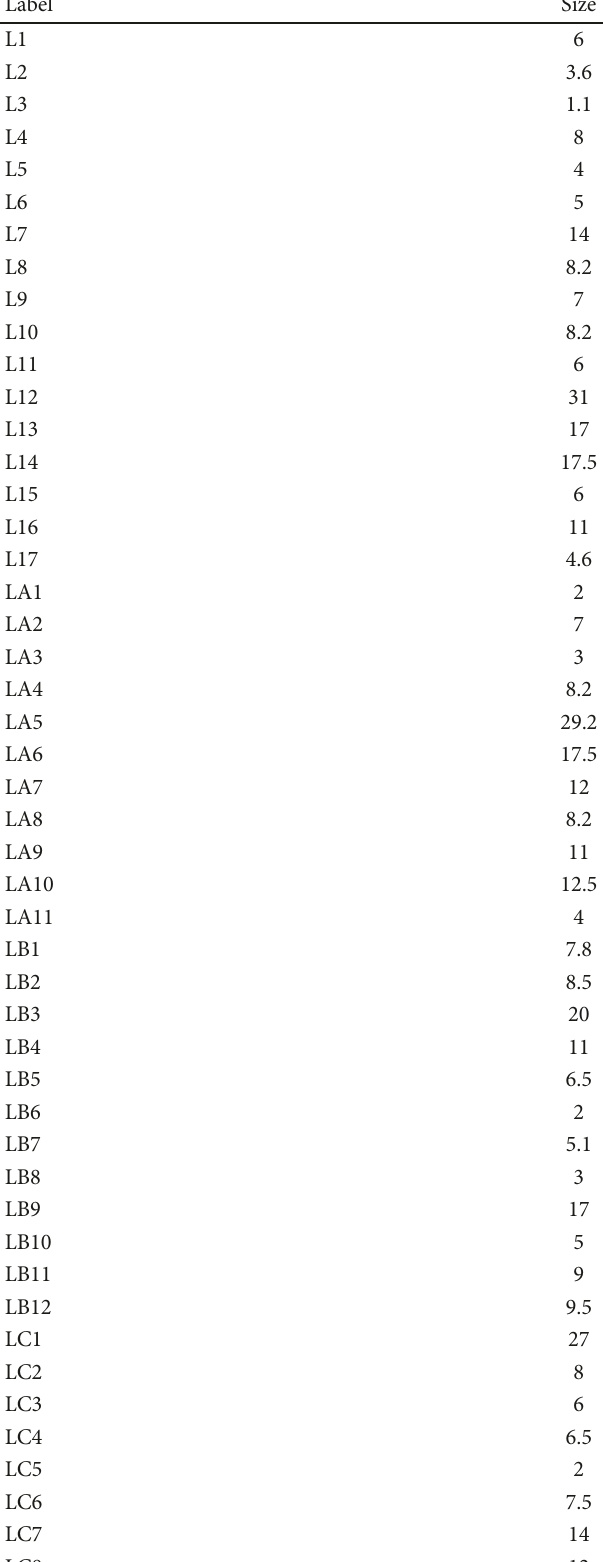
Table 1: Geometric parameters of the antenna and its DGS structure